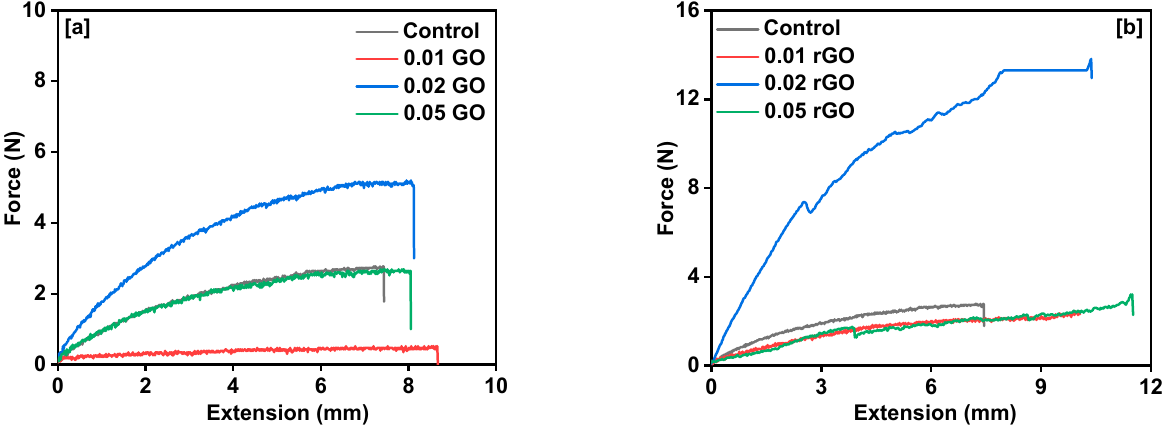
Figure 11. Force–extension curve of films based on ( a ) GO and ( b ) rGO.